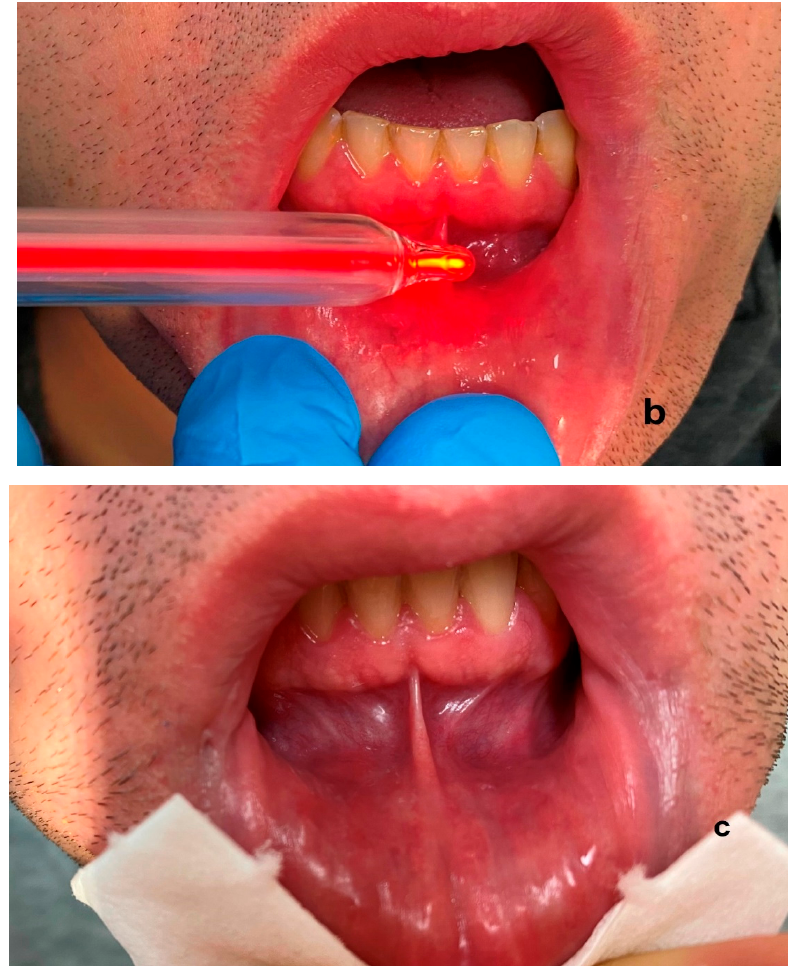
Figure 4. Example of chronic recurrent aphthous ulcers ( a ) before treatment, ( b ) during treatment, ( c ) after three days of ozone therapy. The glass probe of the OzonyTron ozone generator (Mymed) was used (authors’ own photographic documentation).